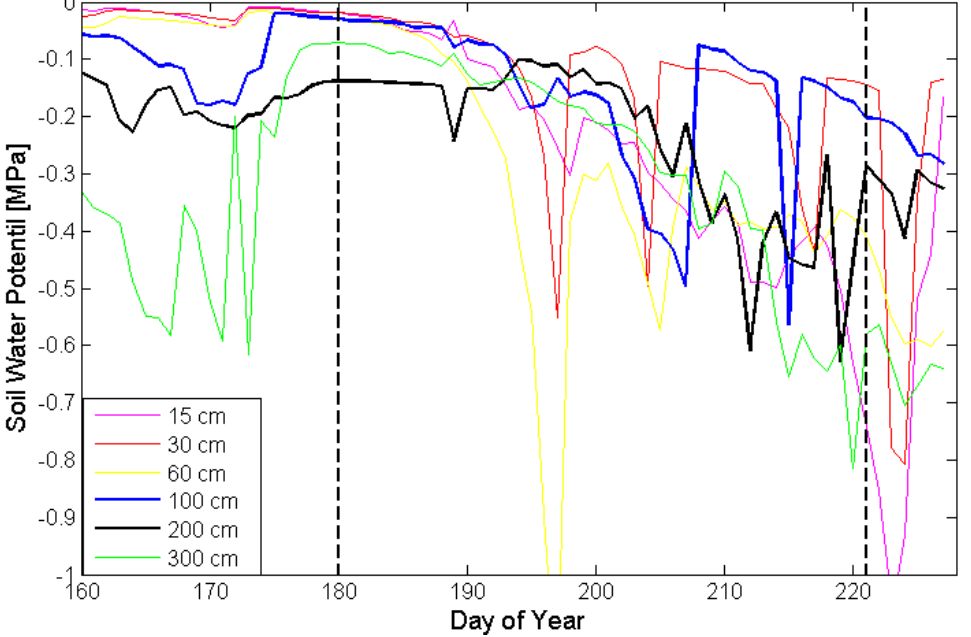
Figure 4. Time series of soil water potential at different depths. The period of the experiment, characterized by a 2-week sequence of low precipitation and consequent drying of the soil column is marked by vertical dashed lines. The soil layers between 100 and 200 cm deep show the lowest variation and never reached below −0.5 MPa during the experiment